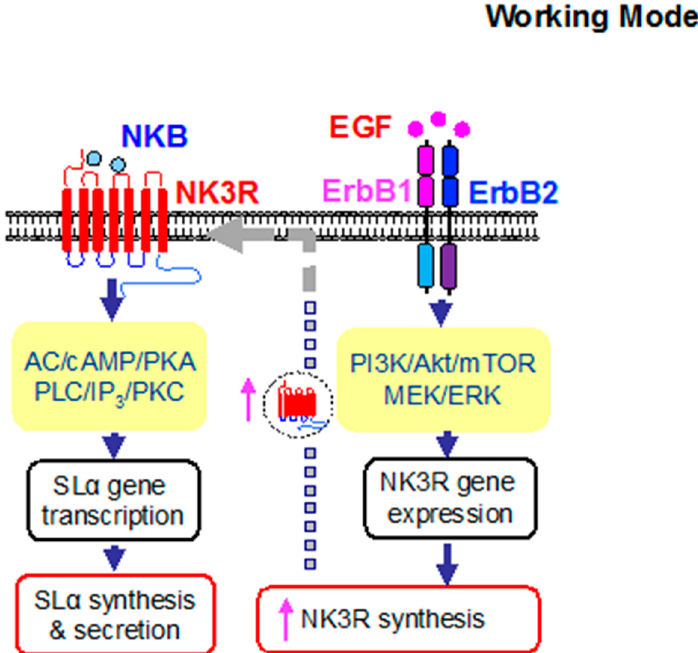
Figure 8. Working model of the interaction between EGF and NKB on SL α mRNA expression in carp pituitary cells. In grass carp pituitary cells, EGF could elevate via activation of ErbB1 and ErbB2 by functional coupling with PI3K/Akt/mTOR, MEK/ERK pathways. The stimulation of NK3R gene expression could contribute to the potentiating effect on NKB-induced SL α mRNA expression, which were mediated by NK3R via functional coupling with the AC/cAMP/PKA and PLC/IP 3 /PKC signaling